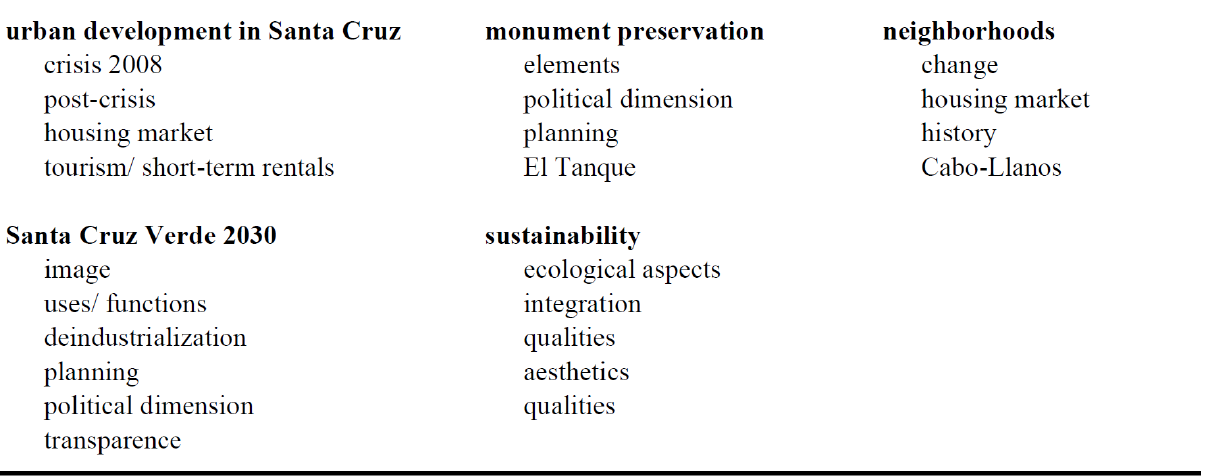
Figure 5. Main categories and subcategories in the qualitative analysis. Own